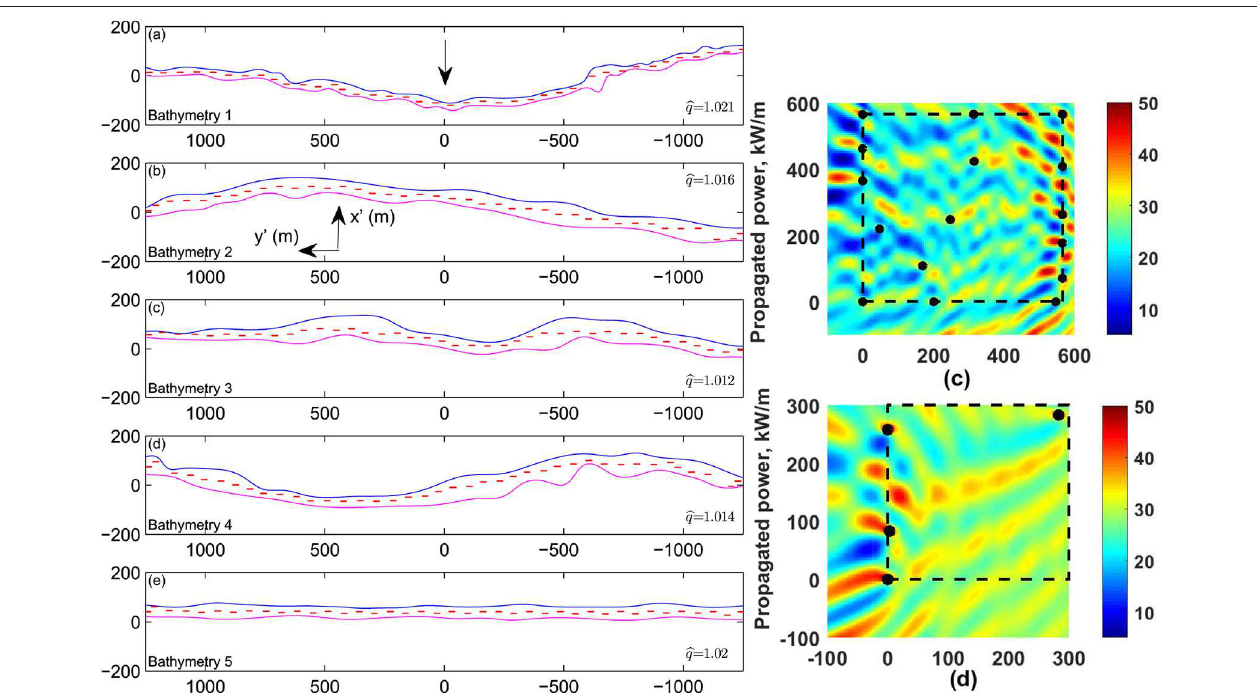
FIGURE 7 | (Left) Optimal layouts of 40 OWSCs obtained with a GA coupled to a machine learning approach for five different bathymetry constraints (shown with blue and pink curves) (Sarkar et al., 2016). (Right) Wave power around optimal arrays with 4 and 16 WECs at a site with waves incident from many directions, found by Neshat et al. (2019b) by a symmetric local search combined with a Nelder-Mead algorithm.